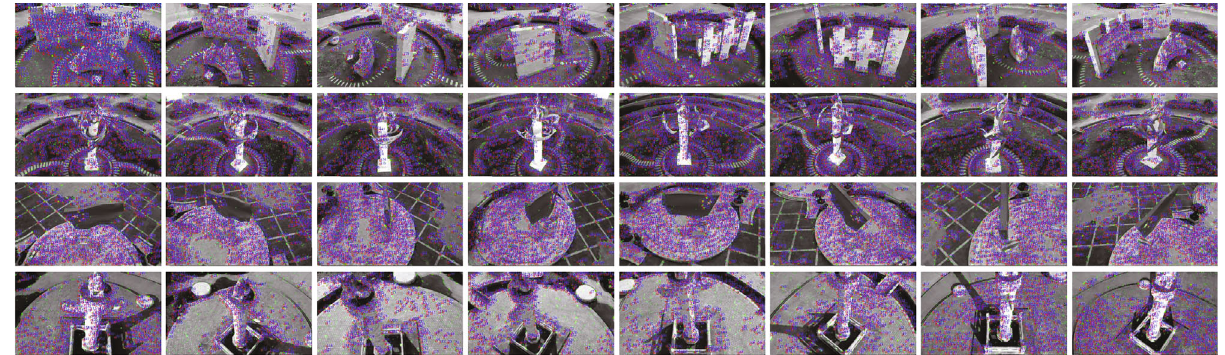
Figure 3: Feature point map of di ff erent angle images (the rotation angle from left to right in order is: 0 ° , 45 ° , 90 ° , 135 ° , 180 ° , 225 ° , 270 ° , and 315 ° ).